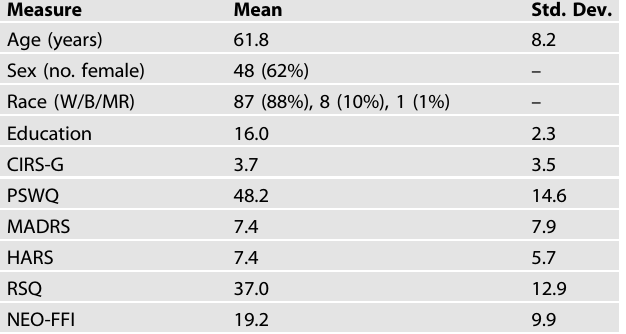
Supplementary Figs. 2 – 4: chord diagrams to show the individual connections and brain maps to show a weighted degree centrality. For the chord diagrams, produced with the R package circlize [56], the individual ROIs are sorted into default mode, limbic, parietal, prefrontal, sensorimotor, subcortical, temporal, and visual groups. Both the color and weight of the line connecting any two ROIs indicate the magnitude of the regression coef fi cient, or how strongly that connectivity is associated with worry. Warm colors are used for positive associations with worry (i.e., greater connectivity and greater worry) and cool colors for negative associations (i.e., lower connectivity and greater worry). The brain maps, visualized with BrainNet Viewer [57], are speci fi c to positive or negative associations to avoid cancellation. The intensity of a region is simply the sum of the regression coef fi cients standardized with respect to worry for positive or